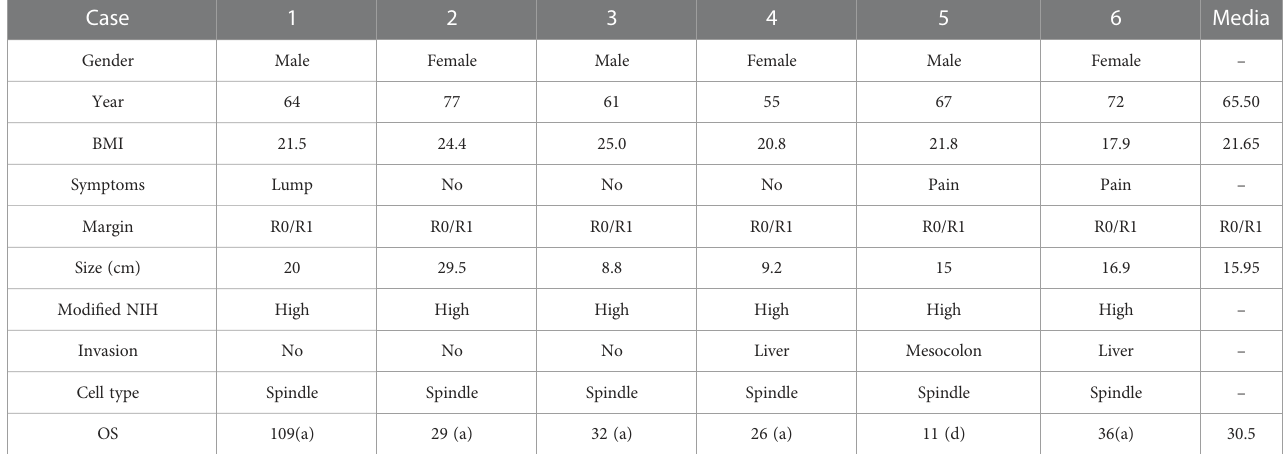
TABLE 1 Baseline features of six patients with retroperitoneal EGISTs.